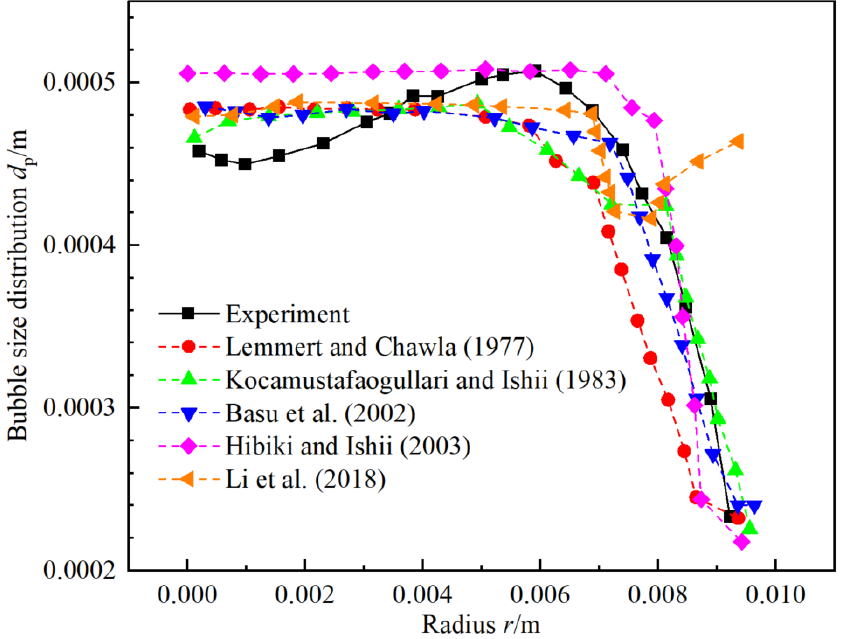
Figure 3. Bubble size distribution of SMD d p of various typical models of N n with model of D d [8], f [46], a ( d i , d j ) [57], Ω ( V p ), β ( f bv , 1) [54] and DEBORA-1 experiment ( P = 2.62 MPa) [28] at z = 3.5 m.